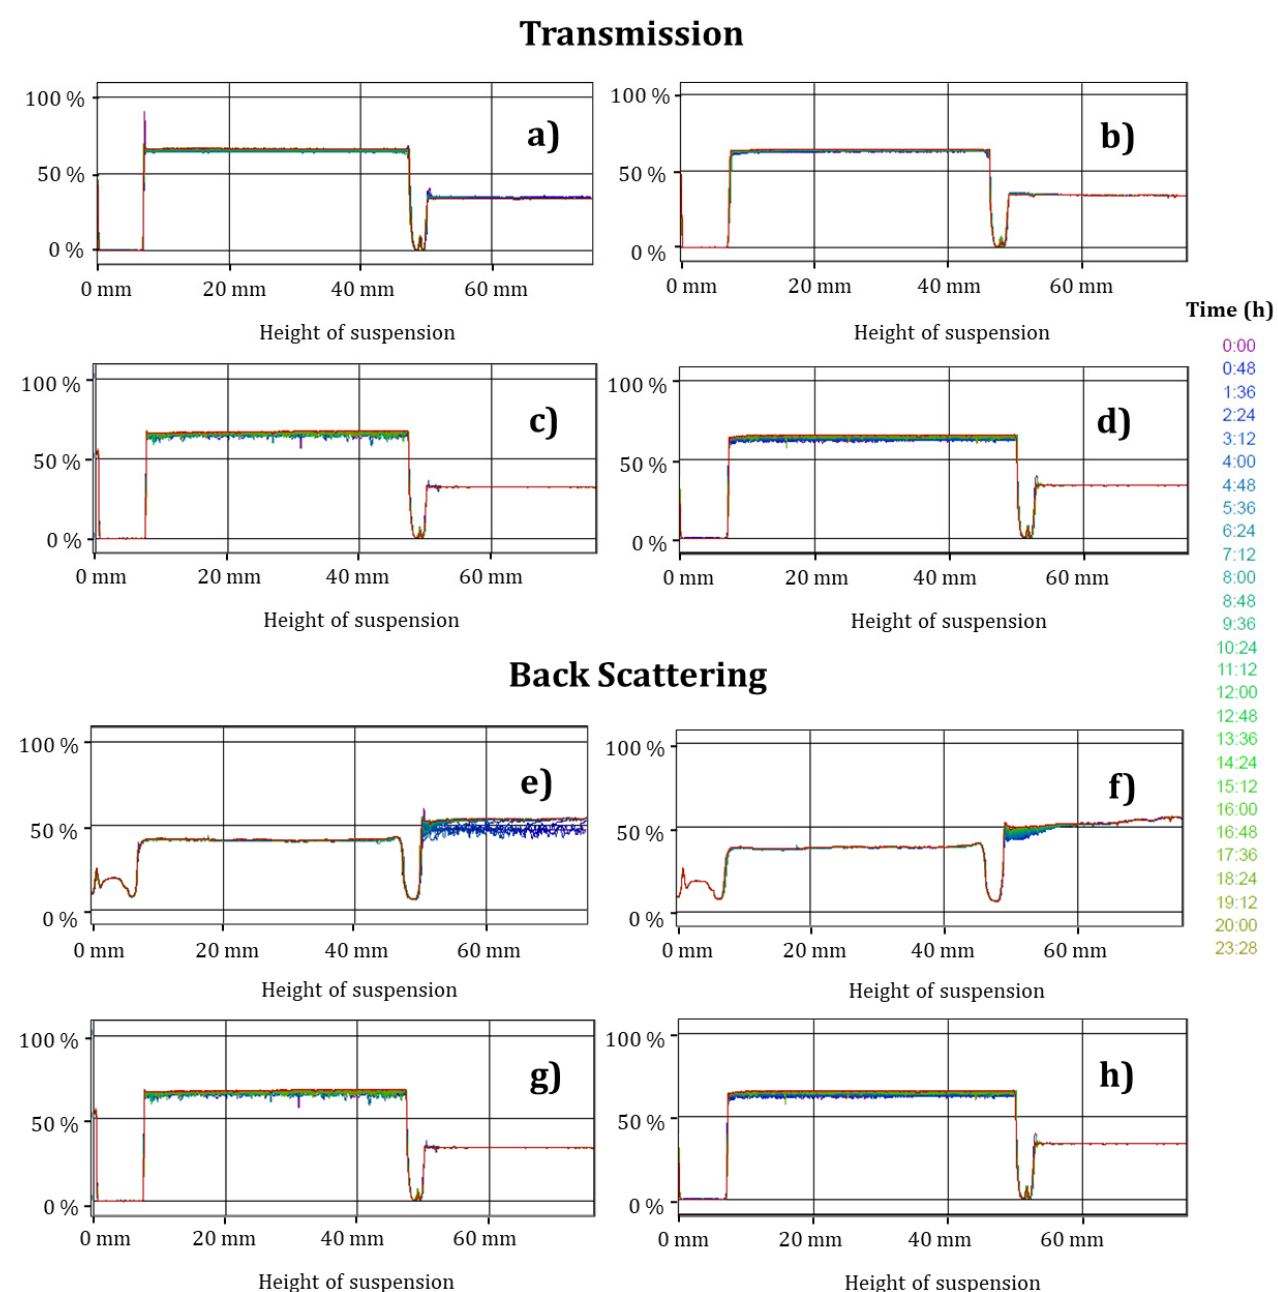
Figure 6. Transmission and backscatter profiles of nanocapsules stored at 4 ◦ C. ( a , e ) initial, ( b , f ) week 1, ( c , g ) week 3, ( d , h ) week 5.